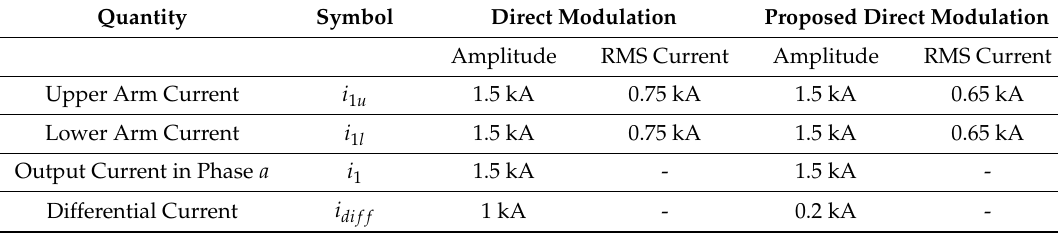
Table 1. Comparison of analytical and simulation results.